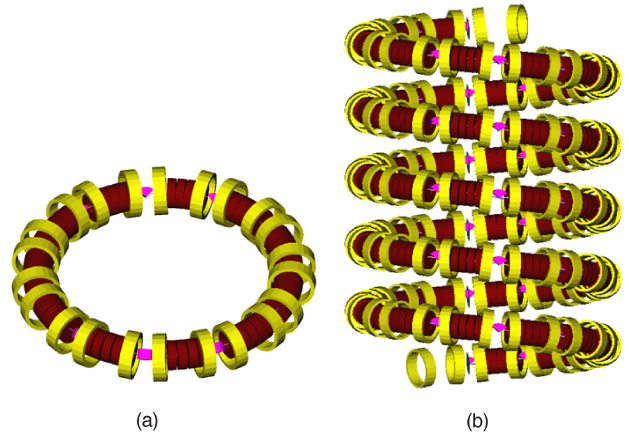
FIG. 1. Some previously considered 6D ionization cooling lattices: (a) Schematic layout of a ring cooler; (b) 5 turn slice of a Guggenheim helix. The large yellow cylinders are solenoids, the small red cylinders are the active volume of the rf cavities, and the magenta wedges are hydrogen absorbers.